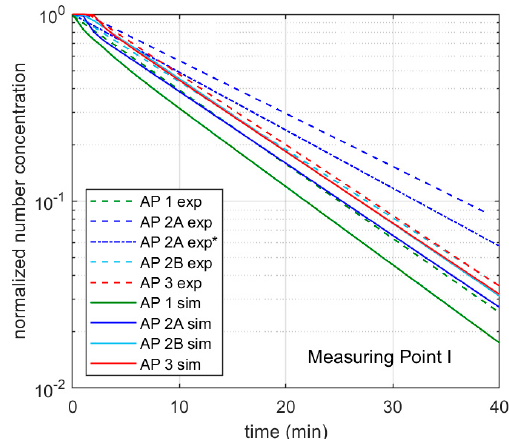
Figure 10. The decay of the normalized aerosol number concentration as a function of time, for the various AP cases, comparison of simulation (sim) with experiment (exp) at measuring point I (see Figure 2) AP 2A exp* shows the decay curve without furniture near the unit.